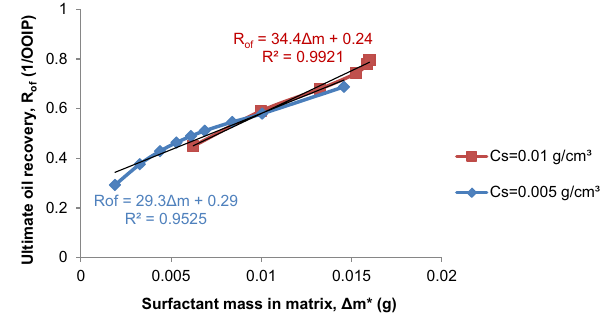
R of = 34.4Δm + 0.24 R² = 0.9921